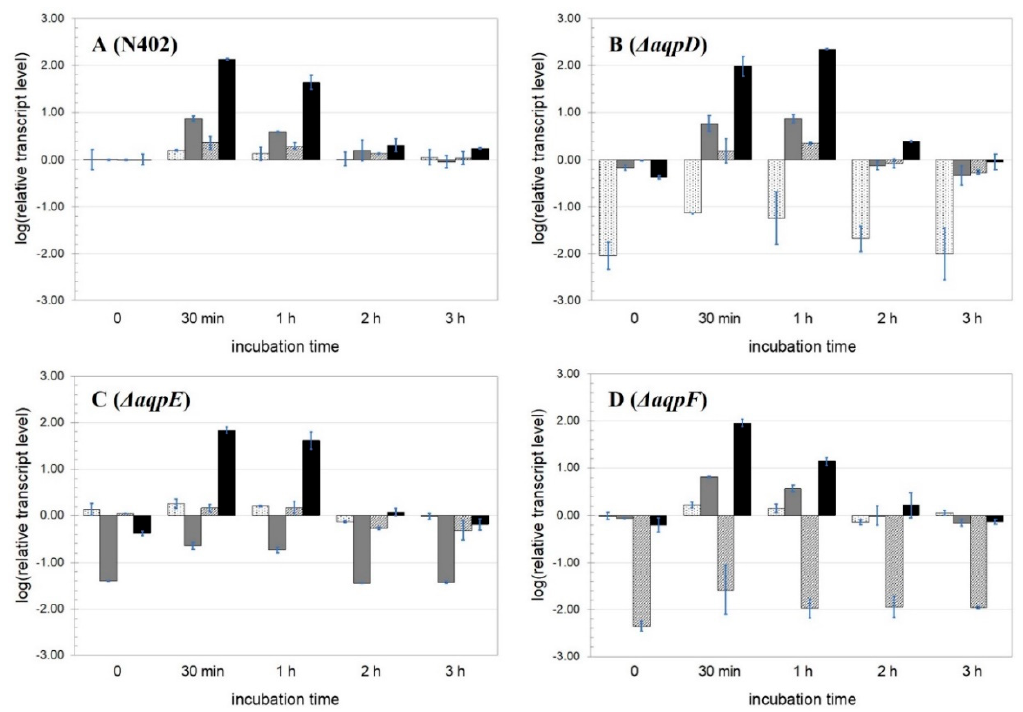
Figure 6. Expression analysis of A. niger wild-type and AQP knock-out strains under hydrogen peroxide-inducing conditions. Results of strain N402 ( A ), ∆ aqpD ( B ), ∆ aqpE ( C ), and ∆ aqpF ( D ). Samples were taken before (0) or at various times after the addition of 10 mM hydrogen peroxide. The expression analyses were performed by RT–qPCR with primers specific for aqpD (white background filled with dots), aqpE (gray bar), aqpF (white background filled with stripes), and goxC (black). The goxC gene was used as a proxy for hydrogen peroxide uptake. The data presented is the mean of two biological replicates using a logarithmic scale (log10).